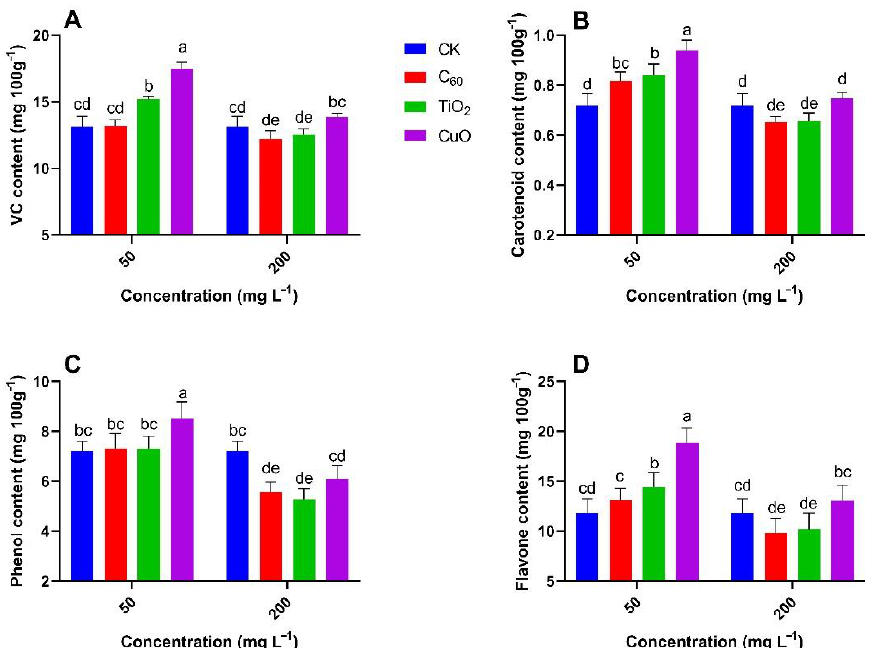
Figure 10. Effect of NMs treatment on the mean content (n = 3) of ascorbic acid ( A ), carotenoids ( B ), total phenol ( C ), and total flavones ( D ) in sweet potato (J26) exposed to soft rot disease. Different small letters represent significant difference according to Duncan’s multiple range test ( p < 0.05. n = 3).